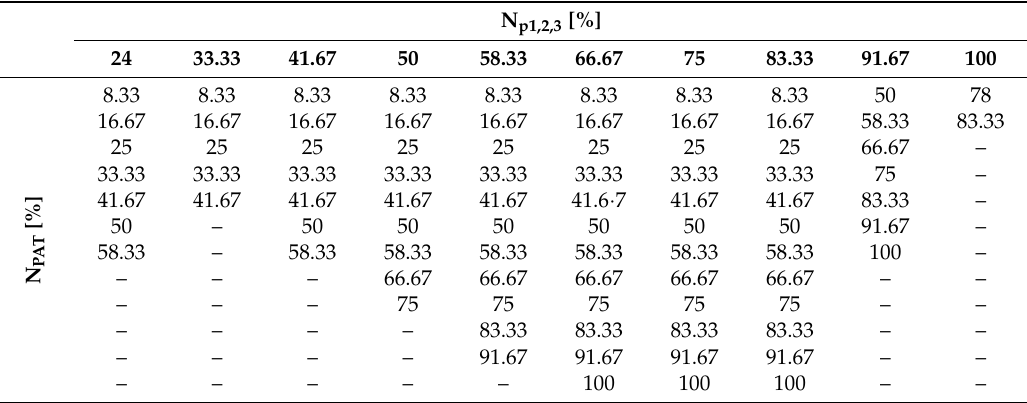
Table 3. Combinations of rotational speeds of the recirculating pumps and of the PAT for performance measurements using the static